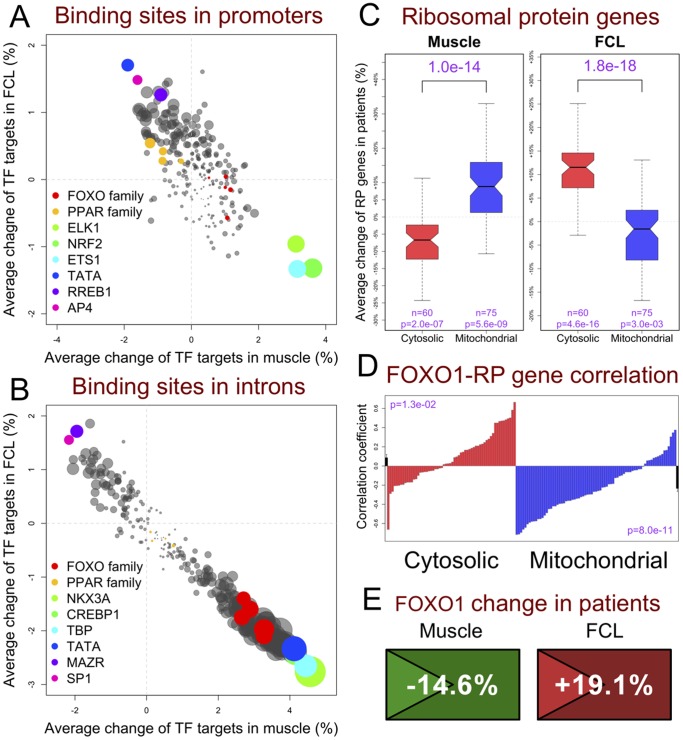
Co-regulation of gene groups by upstream regulators.(A) TF activity analysis of genes with promoter binding sites. Average change of genes whose [−1 kb, 1 kb] promoter regions containing sites matching the position weight matrix (PWM) of 258 transcription factors (TFs) indicated that many TFs had modified activity in primary RC disease. Each dot represents a known TF PWM and its size corresponds to the combined p value in muscle and FCLs. (B) TF activity analysis of genes with intronic binding sites. The same analysis as in (A) was performed on genes whose introns contained sites matching the PWMs. (C) Inverse expression of cytosolic and mitochondrial ribosomal genes in RC disease. Overall differential expression of cytosolic and mitochondrial RP genes in RC disease had opposite patterns in muscle and FCLs. This analysis included genes encoding ribosome subunits, but not RP pseudogenes and genes regulating ribosome biogenesis, such as RRS1 and RPS6KA1. (D) Differential correlation of FOXO1 expression with cytosolic and mitochondrial ribosomal proteins.
FOXO1 was differentially correlated to cytosolic (green) and mitochondrial (blue) RP genes. Each green or blue bar represents the correlation coefficient between FOXO1 and one RP gene summarized from four sample groups of all tissue-disease combinations using the DerSimonian-Laird meta-analysis method. The red bars on both ends indicate the overall average, with p values computed by Student’s t-test. (E) FOXO1
 differential expression at gene and sub-gene levels. Differential FOXO1 expression in both cell types is symbolized as two icons. Colors convey direction (green = down, red = up) and statistical significance of differential expression in RC disease. Triangles on the left are 5'-UTRs whose differential expression was more significant than the respective whole transcript average (see detailed keys in Fig. 6). See also Fig. S6 in File S3.